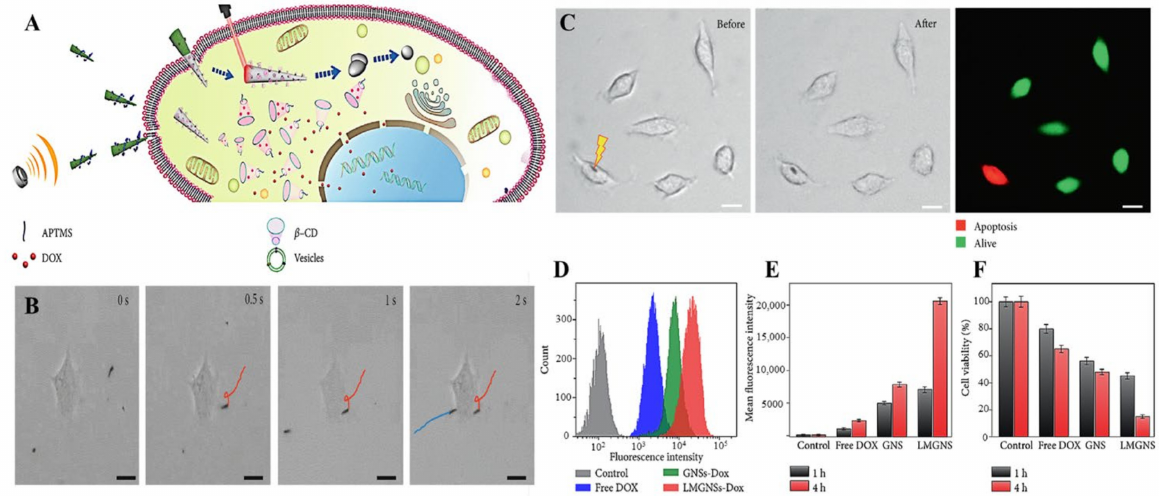
Figure 17. Biomedical application of MLMTs [8]. ( A ) Schematic illustration of the ultrasonically driven MLMTs coated with leukocyte membrane actively target, penetrate, and kill the cancer cell. ( B ) Time-lapse images of ultrasonically driven MLMTs actively seeking and targeting the HeLa cell. Scale bars, 20 µ m. ( C ) Microscopic images of HeLa cells with the MLMTs before and after NIR laser irradiation and the fluorescence image of HeLa cells after NIR irradiation. ( D ) Quantitative Dox release analysis of the free Dox, GNS-Dox, and MLMTs-Dox treatments for 4 h by flow cytometry. ( E ) Mean fluorescence intensity of Hela cells incubated with PBS, free Dox, GNSs-Dox, and MLMTs-Dox for 1 and 4 h. ( F ) Therapeutic efficiency of free Dox, GNSs-Dox, and MLMTs-Dox to HeLa. All scale bars, 20 µ